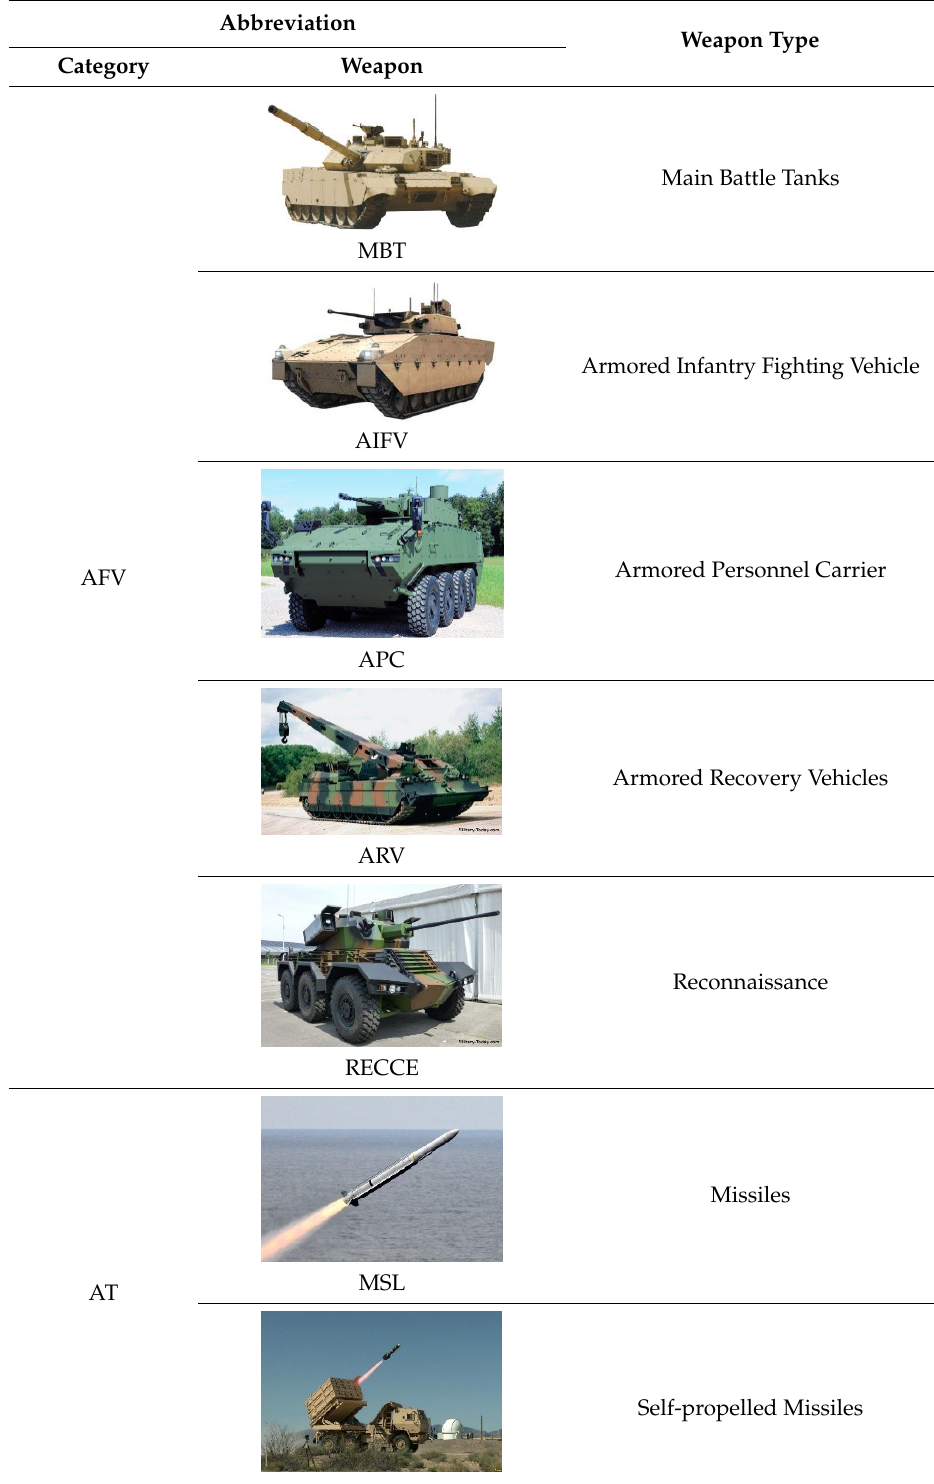
Table 1. Weapon types and abbreviations. Armoured Fighting Vehicle; Anti-Tank, Artillery. Table 1 . Weapon types and abbreviations. Armoured Fighting Vehicle; Anti-Tank,